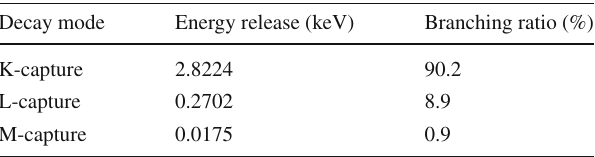
Table 1 Energy release and branching ratios of decay modes of 37